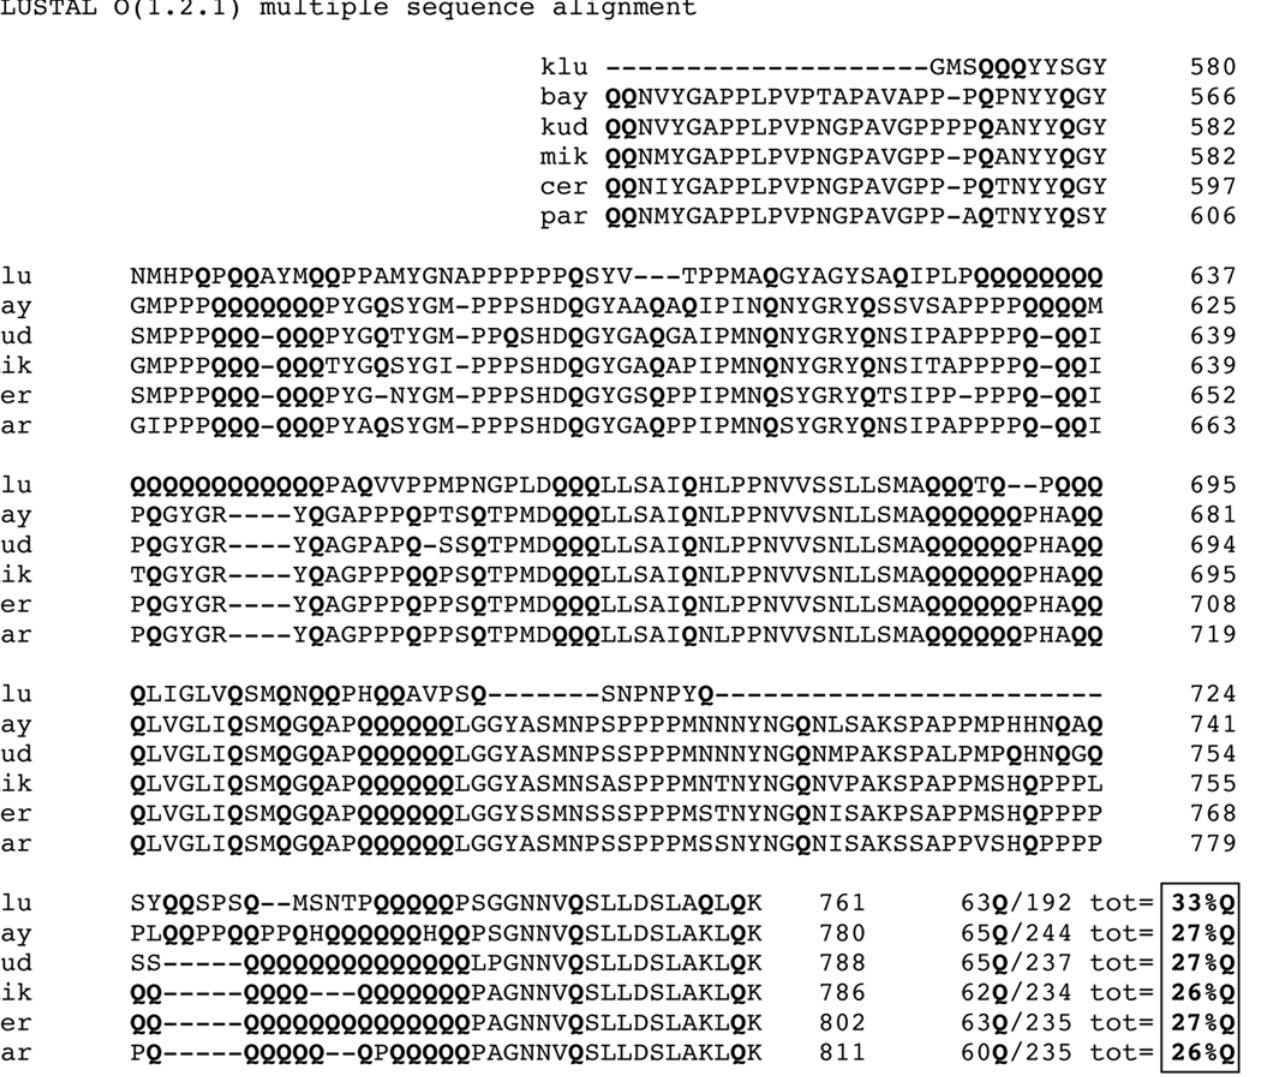
Fig 6. Alignment of Saccharomyces Nab3 LCDs. The prion-like domain of Nab3 as defined by Alberti et al . (2009) was aligned using CLUSTAL Omega with the cognate region from S . kluyveri , S . bayanus , S . kudriavzevii , S . mikatae , and S . paradoxus . The numbering of amino acids for each is shown at right. Glutamine residues ( Q ) were tallied for each species, divided by the total number of residues in its LCD (tot), and described as a percentage thereof in the box at lower